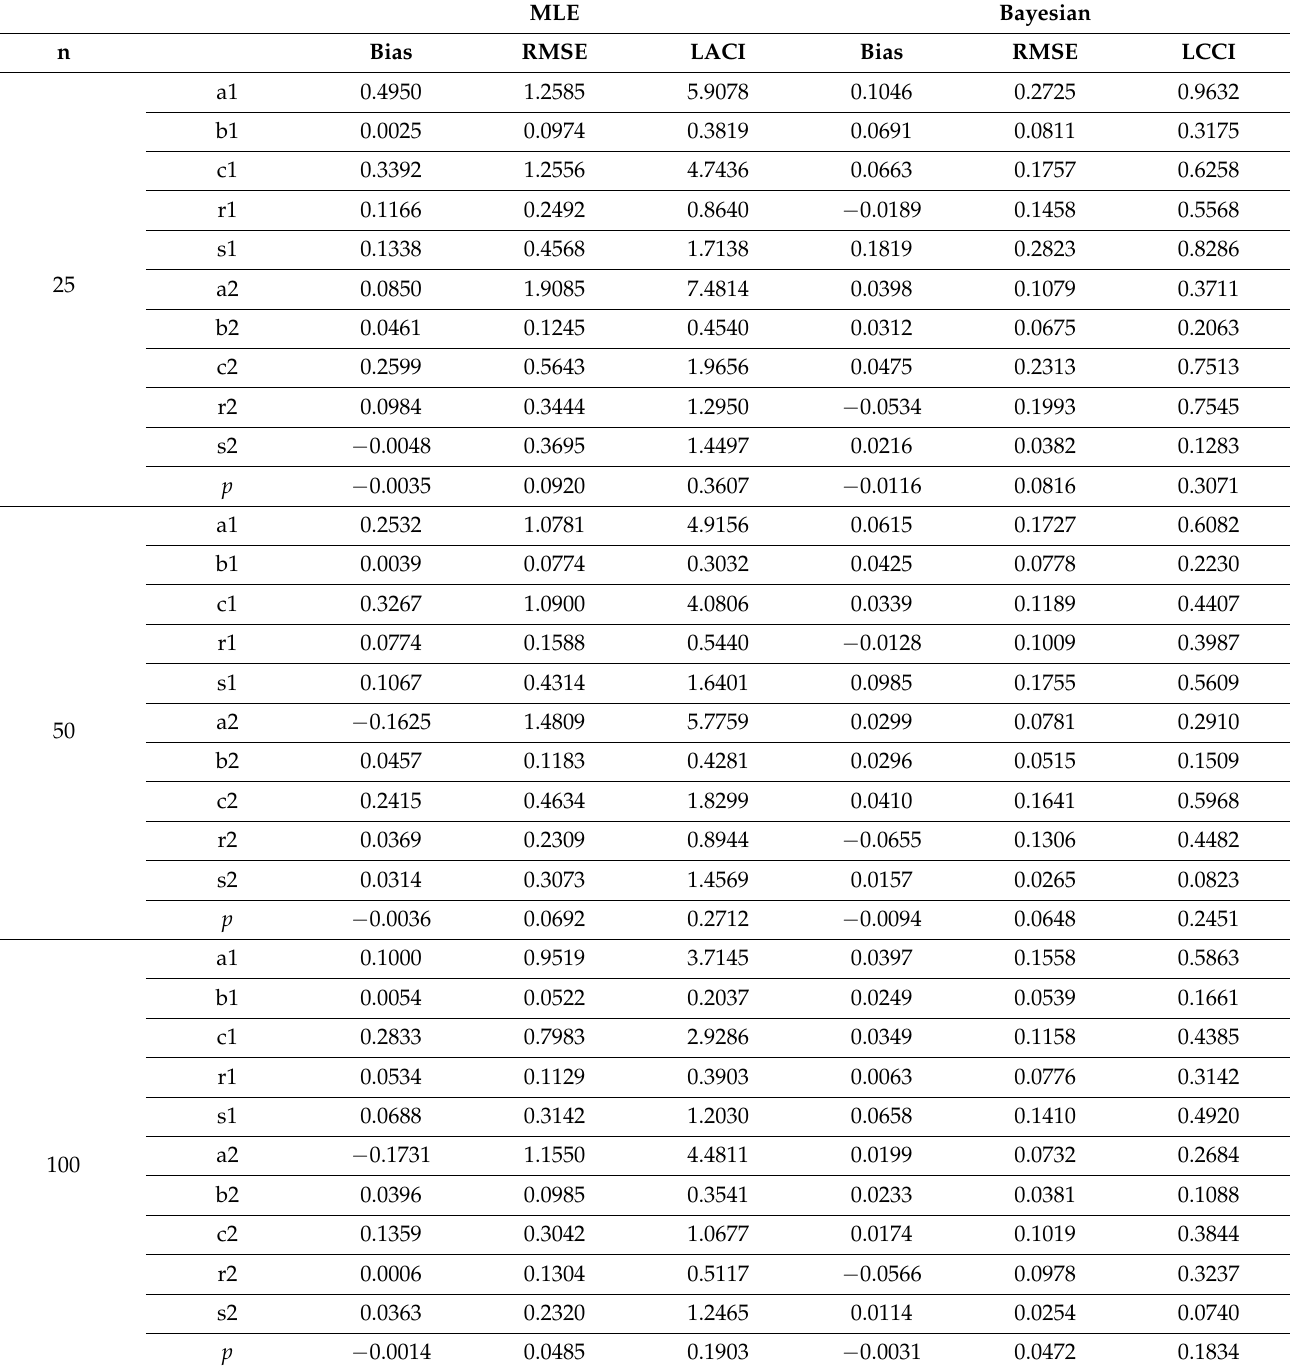
Table 5. Bias, RMSE and length of CI for the MLE and Bayesian estimates of the parameters are presented for different sample sizes: Scheme 1 (complete sample), Case